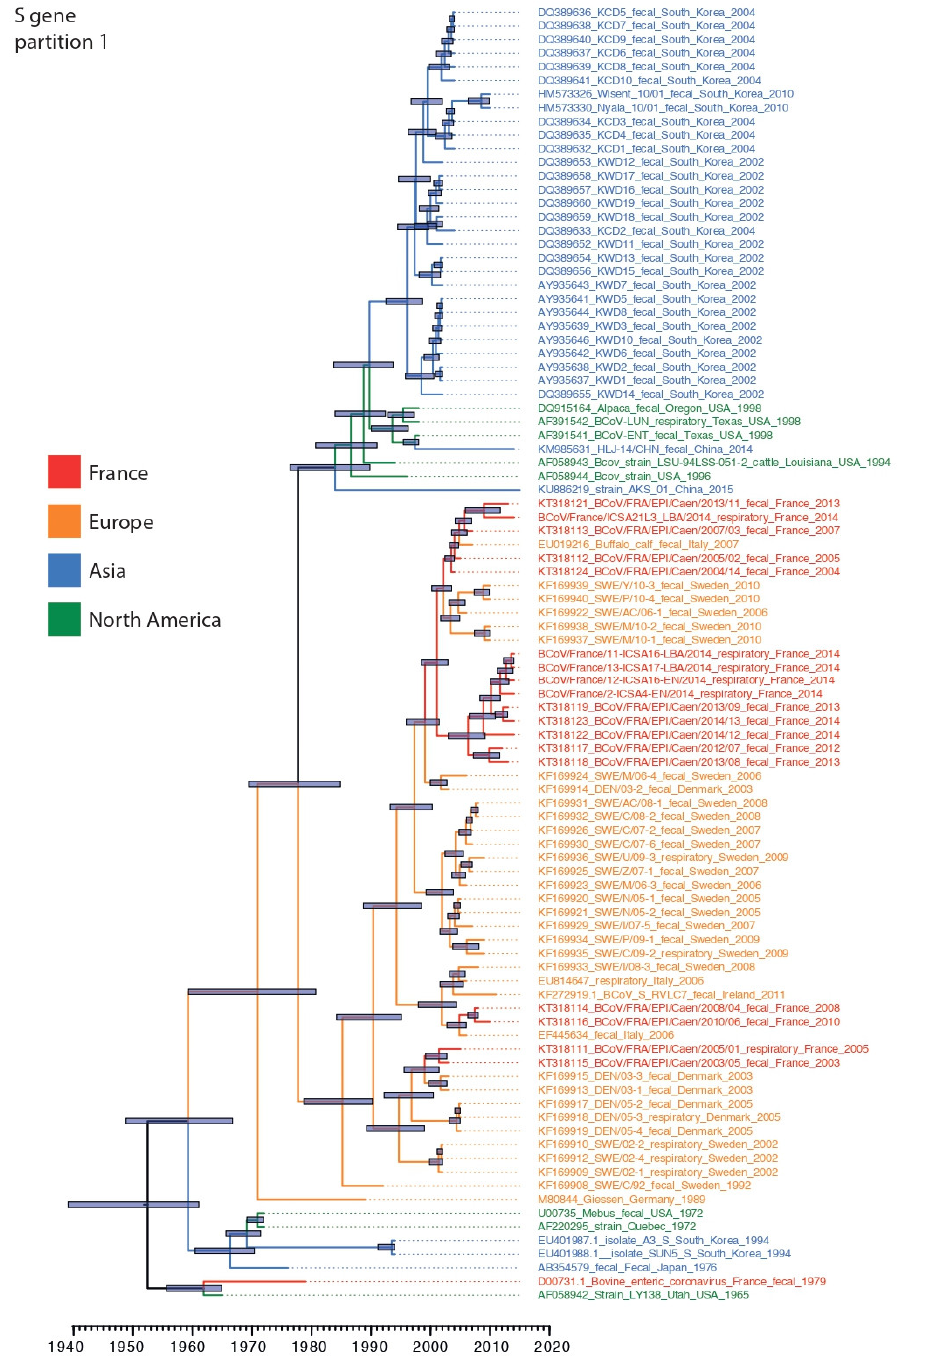
Figure 1. Dated phylogeny of BCoV S gene partition-1 (nt 1–1100). Tree generated using the relaxed clock model and a constant coalescent tree prior. Nodes correspond to mean tMRCAs. 95% highest